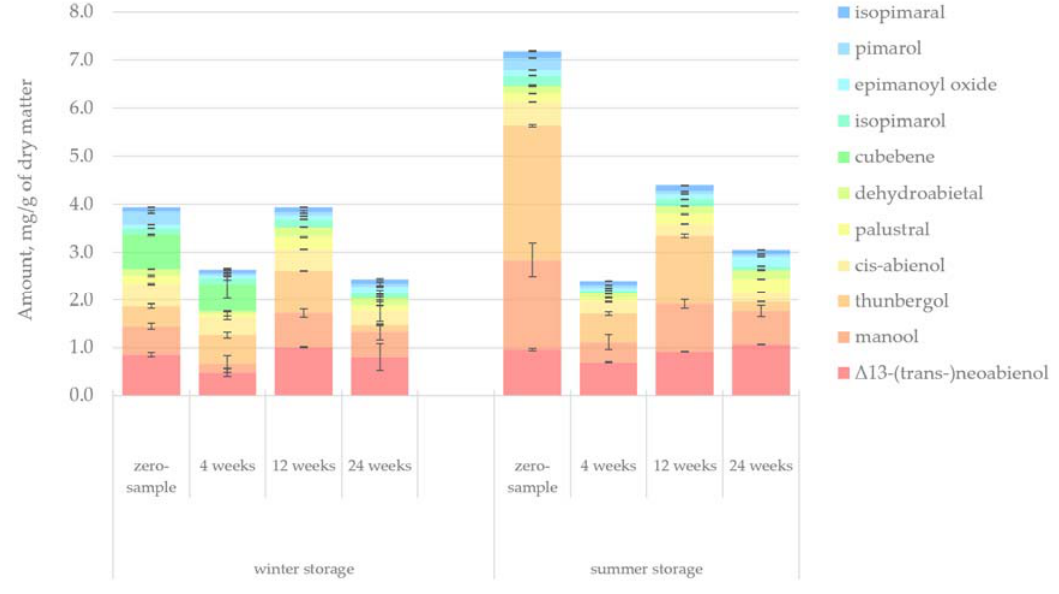
Figure 8. The changes in diterpenoids during summer and winter storage periods of saw log bark.